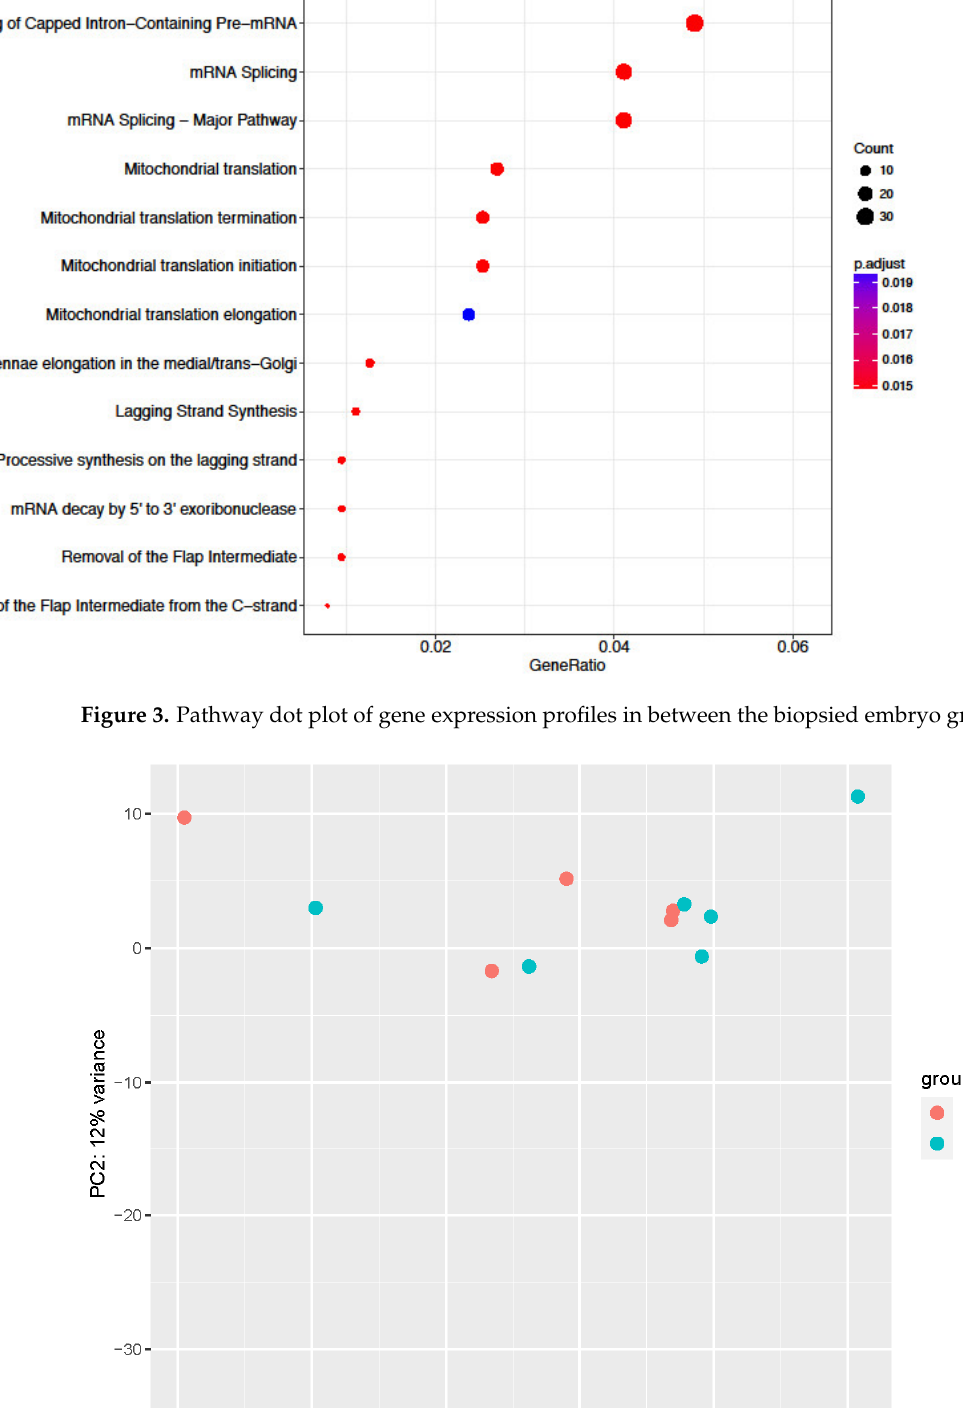
embryos which development was arrested at morula .